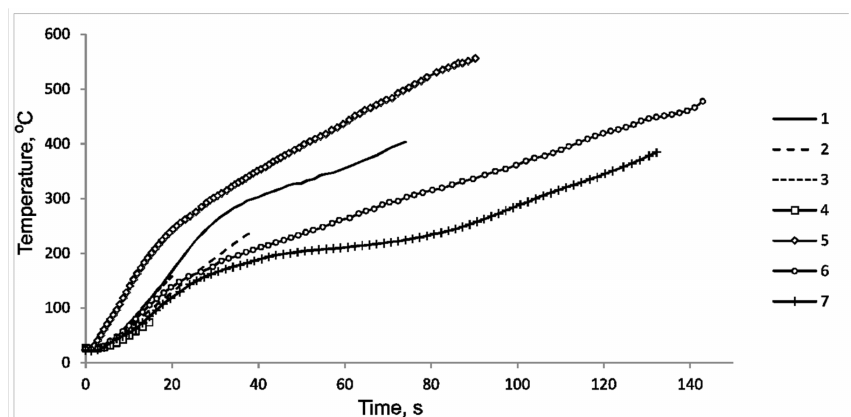
Figure 5. The temperature inside